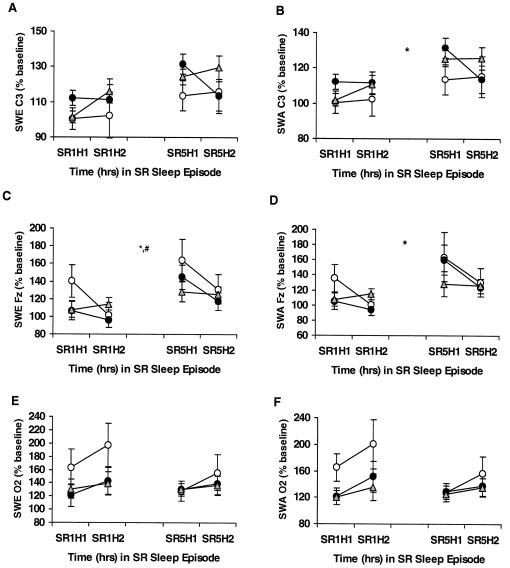
Slow-wave activity (SWA) and slow-wave energy (SWE) during sleep deprivation for the COMT Val158Met genotypes.Mean (±SEM) hourly SWA and SWE as a percentage of baseline at the same corresponding hour derived from the C3 (A, B), Fz (C, D) or O2 (E, F) channels on partial sleep deprivation/restriction night 1 (SR1) and partial sleep deprivation/restriction night 5 (SR5) for hour 1 (H1) and hour 2 (H2) in Met/Met (open circles), Val/Met (gray triangles) and Val/Val (closed circles) subjects. Met/Met subjects showed differentially greater dissipation during sleep restriction nights in NREM EEG SWE (derived from the Fz channel)—the putative homeostatic marker of sleep drive—compared with Val/Met and Val/Val subjects (denoted by #, p<0.05). SWA and SWE derived from the Fz and C3 channels increased from SR1 to SR5 (denoted by *, p<0.05). In some records, EEG signal quality was insufficient or contained too much artifact for reliable power spectral analysis. Thus, the final sample sizes were as follows: for SR1 and SR5 C3, Met/Met (n = 15), Val/Met (n = 56) and Val/Val (n = 37) subjects; for SR1 and SR5 Fz, Met/Met (n = 13), Val/Met (n = 54) and Val/Val (n = 36) subjects; for SR1 and SR5 O2, Met/Met (n = 14), Val/Met (n = 48) and Val/Val (n = 36) subjects.